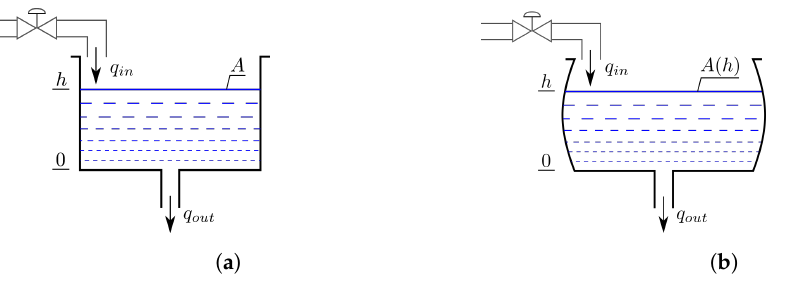
Figure 1. Control techniques of the most basic single-tank level process. ( a ) Controlled inflow. ( b ) Input controlled geometry-varying